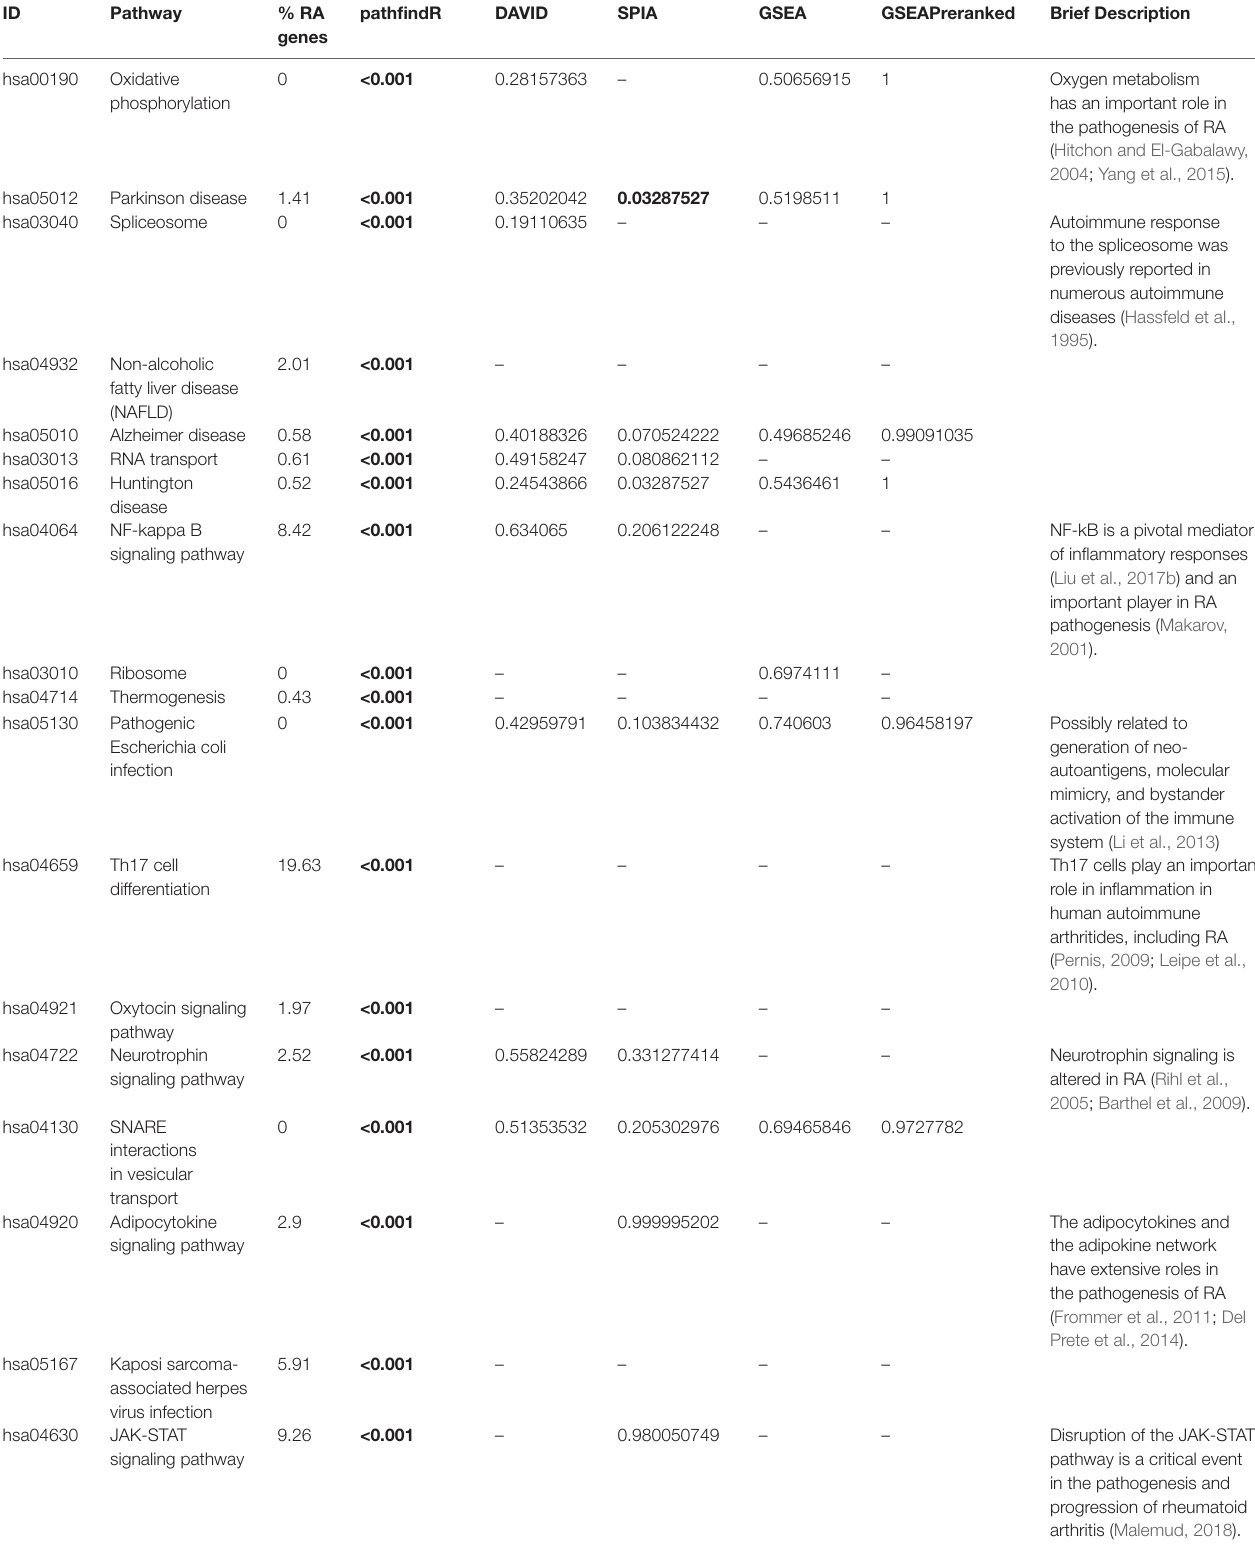
TABLE 1 | Pathway analysis results for the rheumatoid arthritis (RA) dataset (adjusted p <